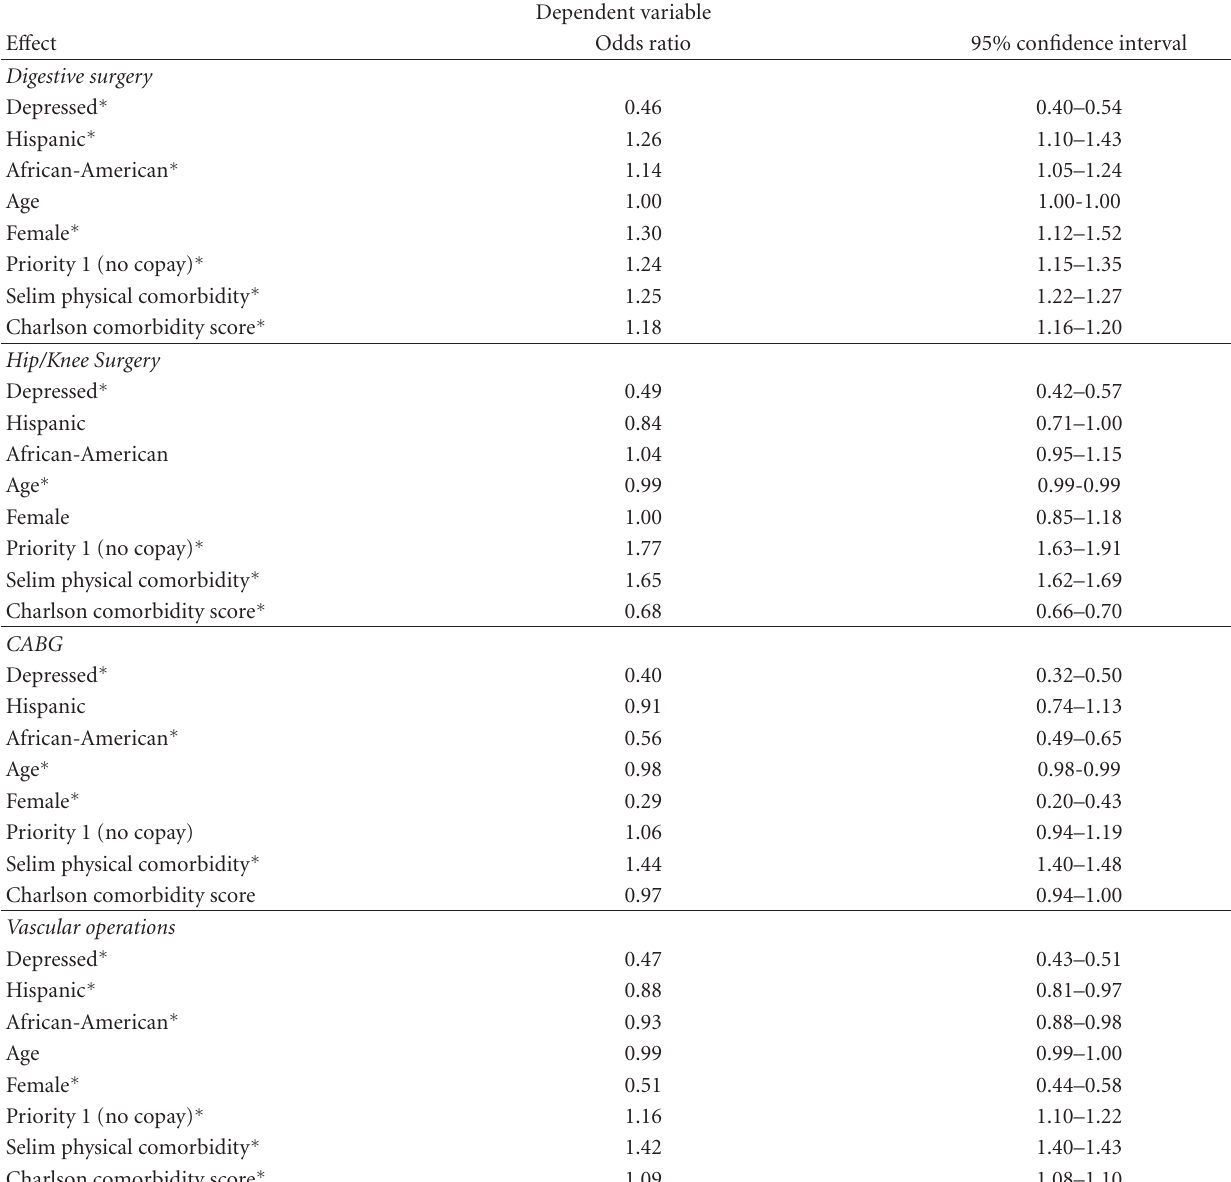
Table 4: Odds ratios associated with race and ethnicity indicators for patients undergoing surgery in the VHA ( N =